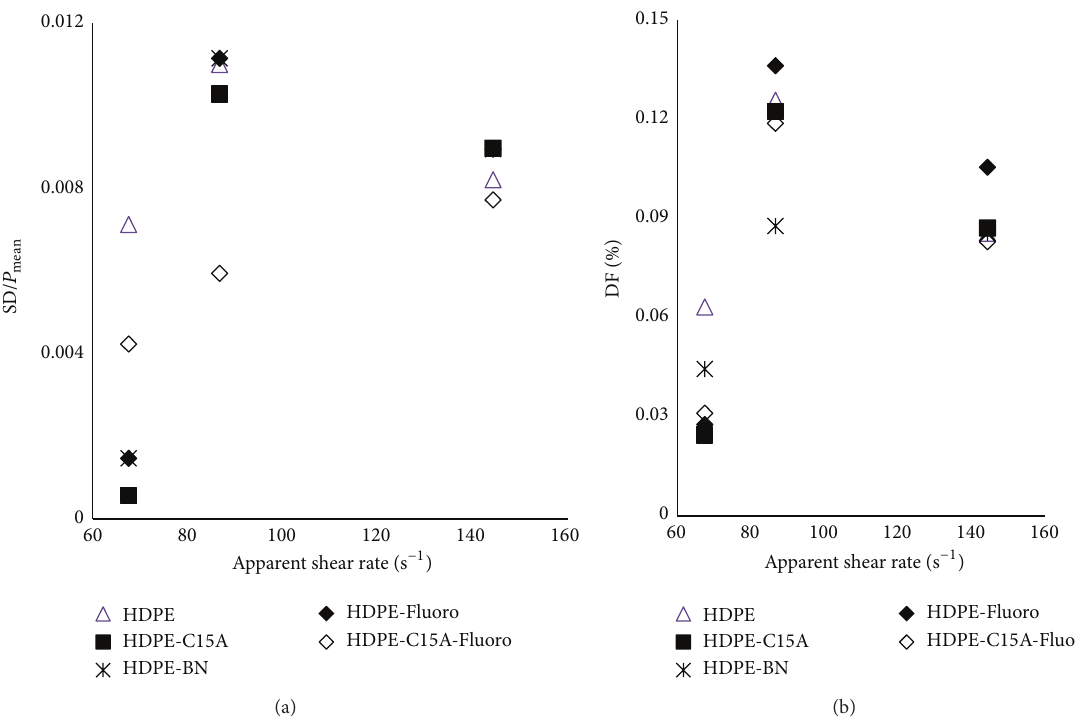
Figure 11: (a) Ratio of standard deviation and the mean pressure. (b) Distortion factor as a function of apparent shear rate for HDPE, HDPE- C15A, HDPE-BN, HDPE-Fluoro, and HDPE-C15A-Fluoro at transducer 1 position.